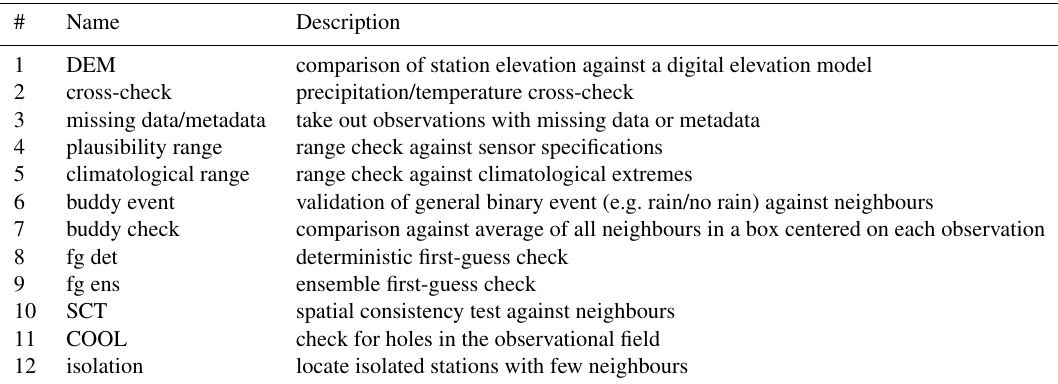
Table 1. List of sequential checks for temperature and